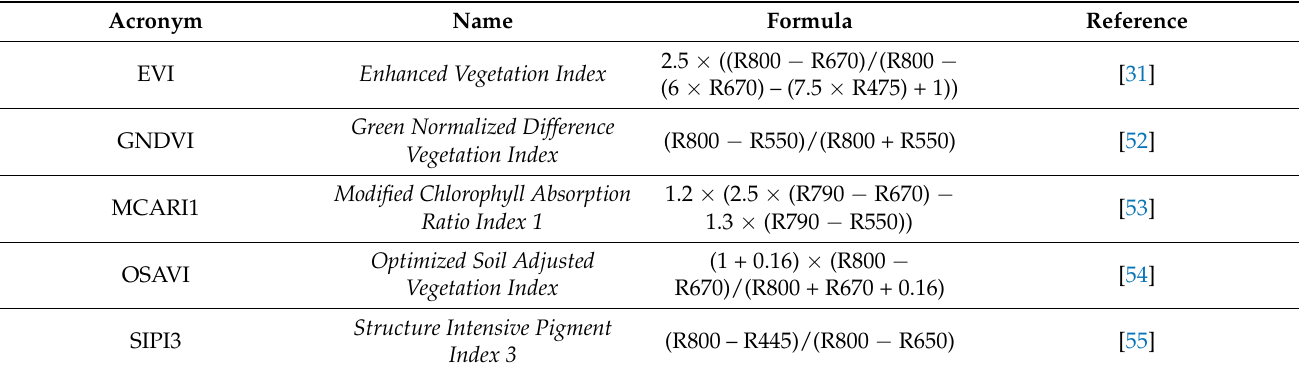
Table 3. Remote sensing vegetation indices (VIs) calculated on Sentinel-2 and AISA